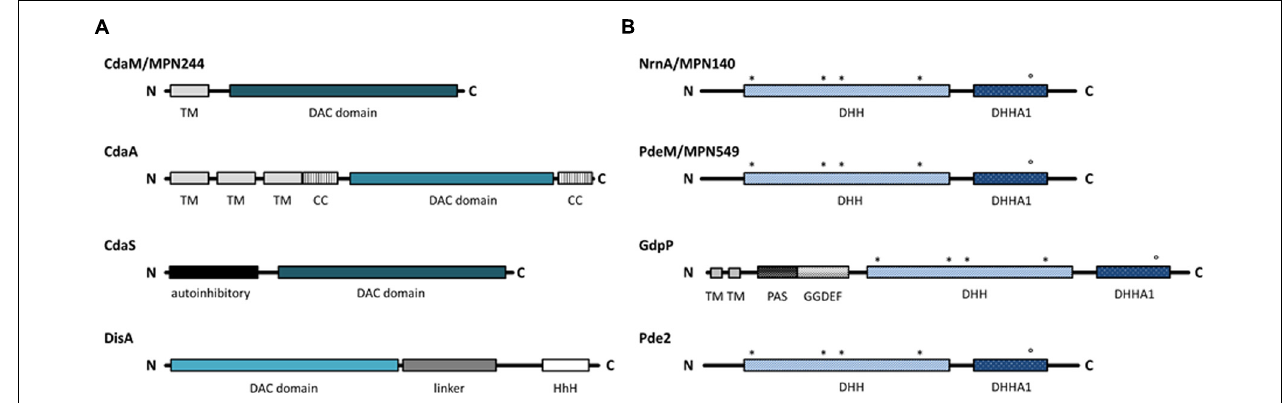
FIGURE 1 | Domain architecture of c-di-AMP related enzymes. Black lines indicate protein sequences and the boxes represent domains. (A) The four classes of c-di-AMP producing DACs. Intensity of the blue color indicates differences in the DAC domain. (B) Phosphodiesterases specific for c-di-AMP degradation. Conserved residues in the DHH and DHHA1 motifs are indicated with asterisks and circle, respectively. DAC, di-adenylate cyclase; TM, transmembrane domain; CC, coiled-coil domain; HhH, Helix-hairpin-Helix; PAS, Per-Arnt-Sim sensor domain; DHH/DHHA/GGDEF, Asp-His-His/ Asp-His-His-Ala/